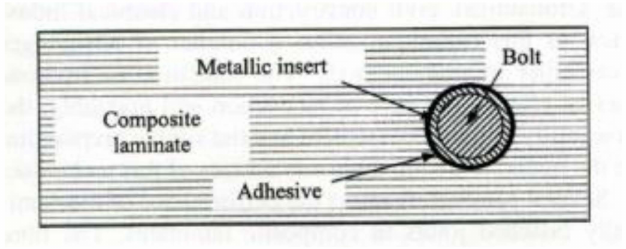
Figure 16. Metallic insert between the bolt and the laminate